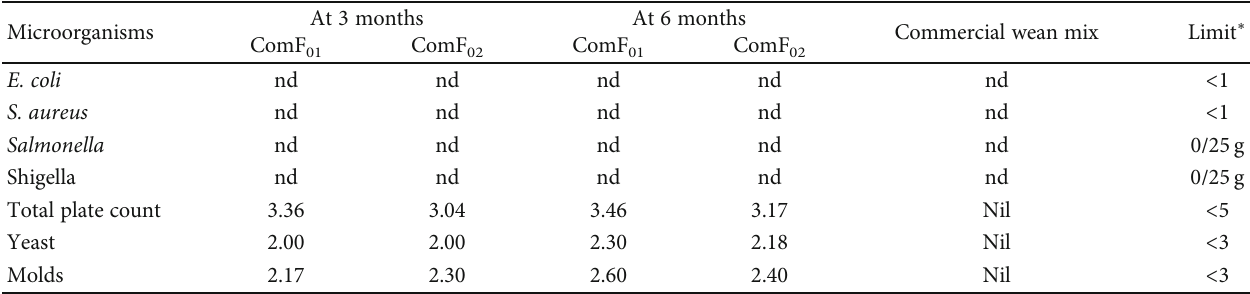
Table 7: Microbiological counts (log CFU/g) of the developed complementary foods after three and six months of storage and commercial 10 wean